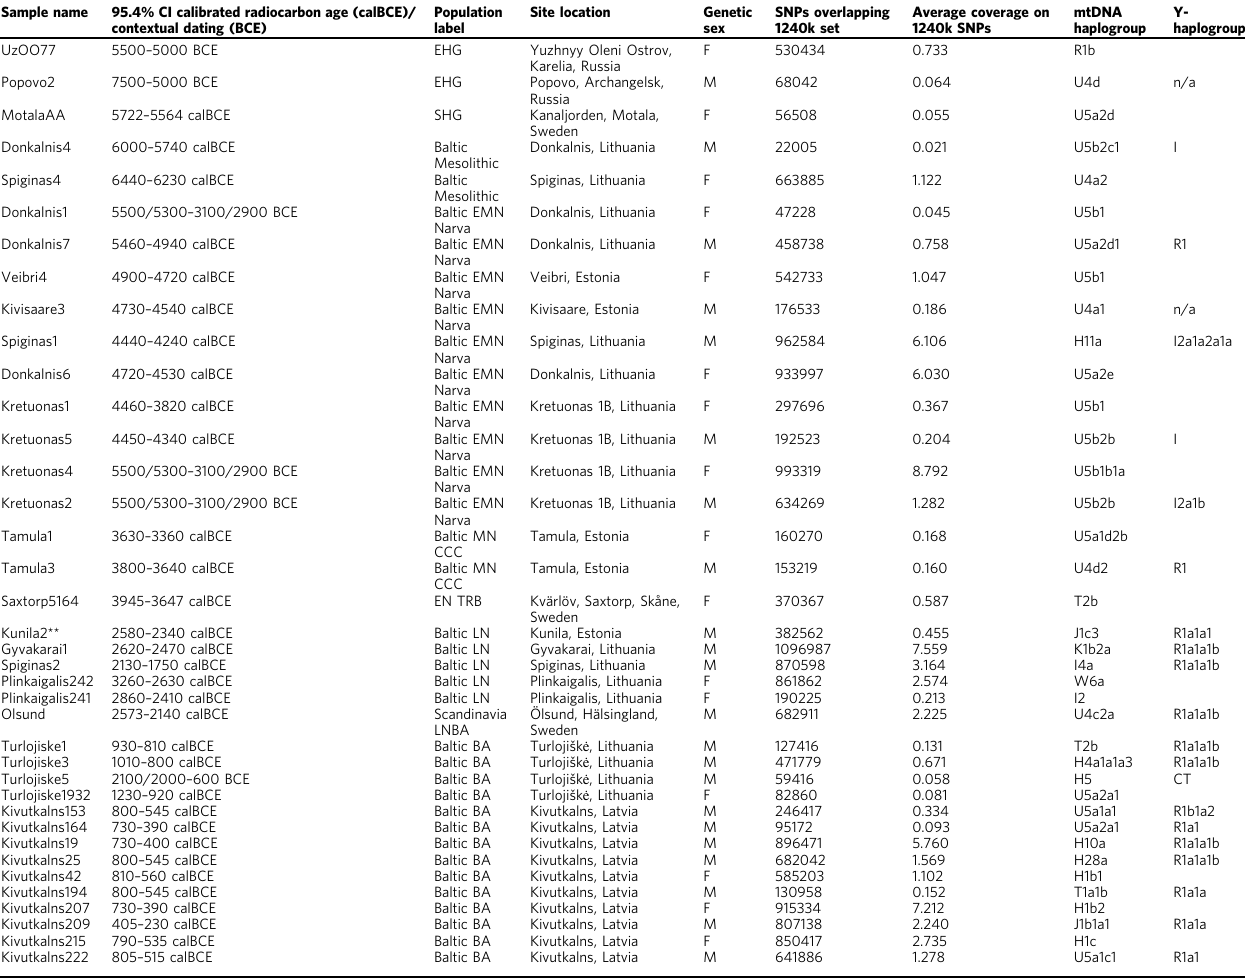
Radiocarbon dates for Spiginas1 and Donkalnis7 were fi rst reported in ref. 28 , radiocarbon dates for Spiginas2, Donkalnis6, Kretuonas5, Gyvakarai, and Turloji š k ė 1 were fi rst reported in ref. 30 *Y-haplogroups are based on the most downstream de fi ning mutation covered and might not re fl ect the true haplogroup, see Supplementary Note 3 **Data merged with published data from this individual